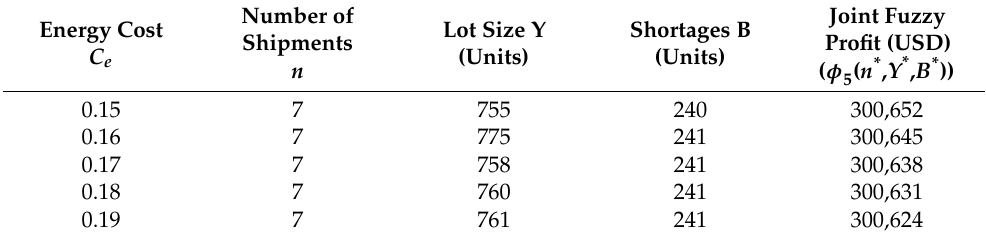
Table 20. Impact of the energy cost on the decision variables and joint fuzzy profit.